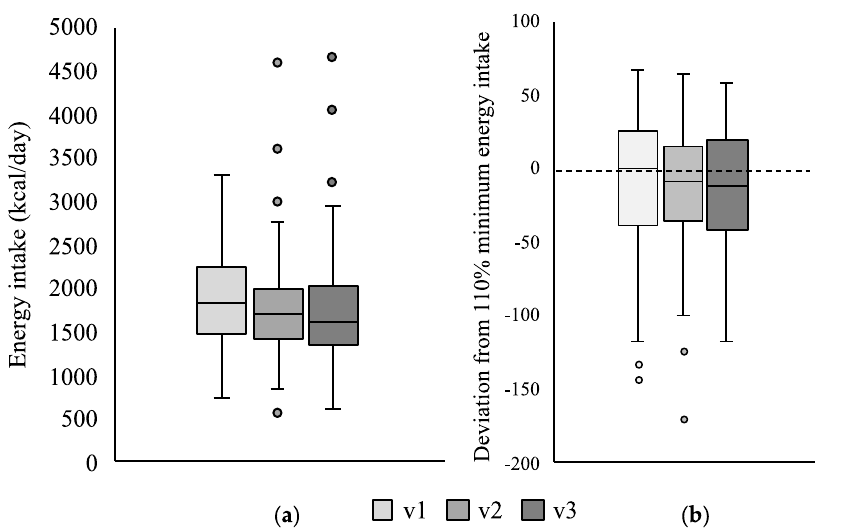
Figure 1. Change in daily energy intake along the three study visits (v1, baseline; v2, month 3; v3, month 6) in the study cohort ( n = 84). ( a ) expressed as median kcal/day; ( b ) expressed as deviation% from minimum recommended daily energy intake (110% with respect to age and gender-matched populations, represented by horizontal dotted line) [3].